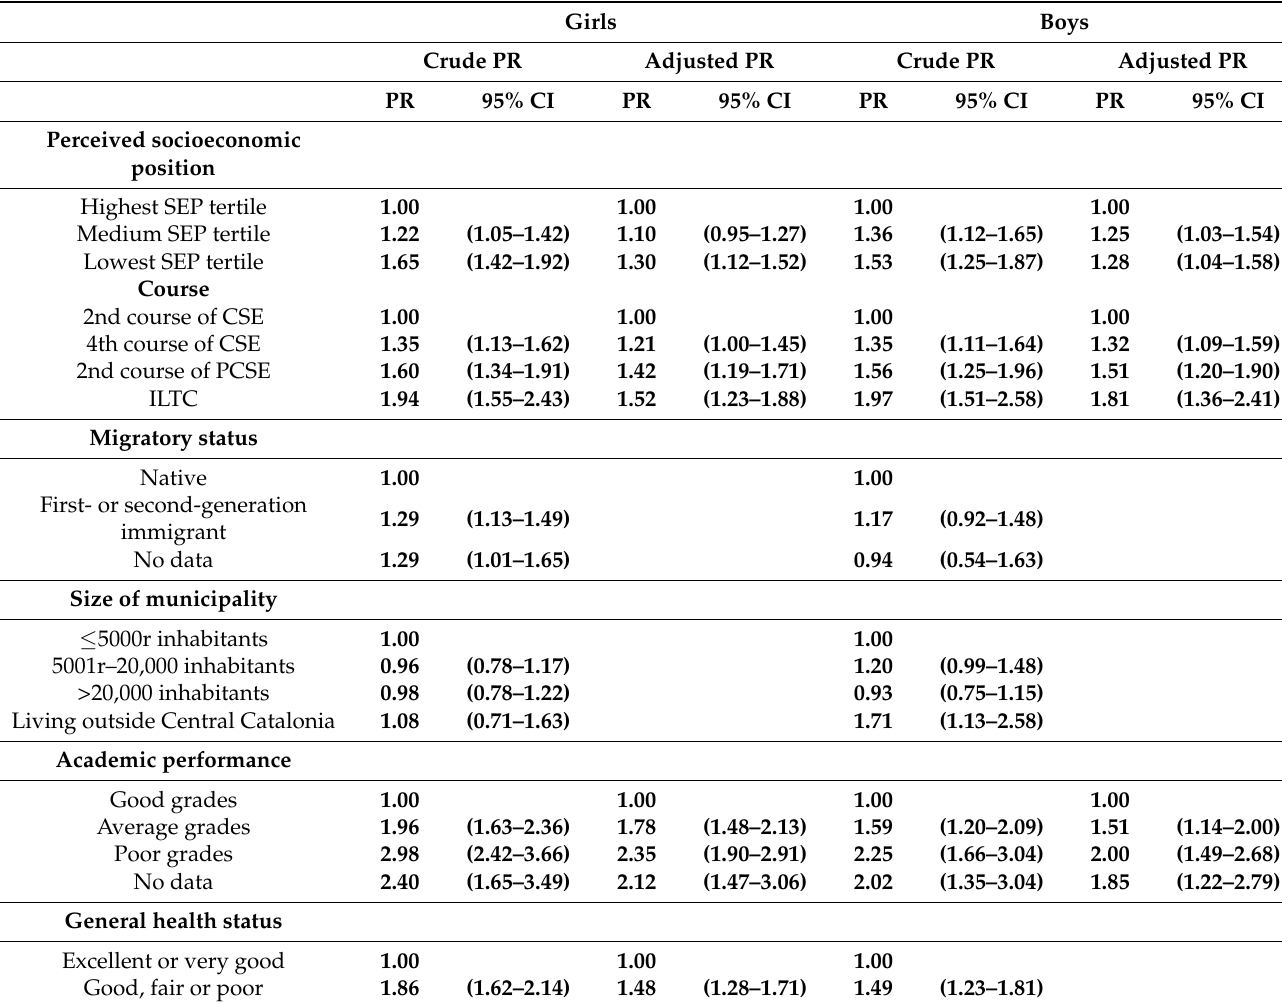
Table 3. Prevalence ratios (PR) of skipping breakfast every day in the last week in 12- to 18-year-old adolescents from Central Catalonia, estimated using Poisson regression